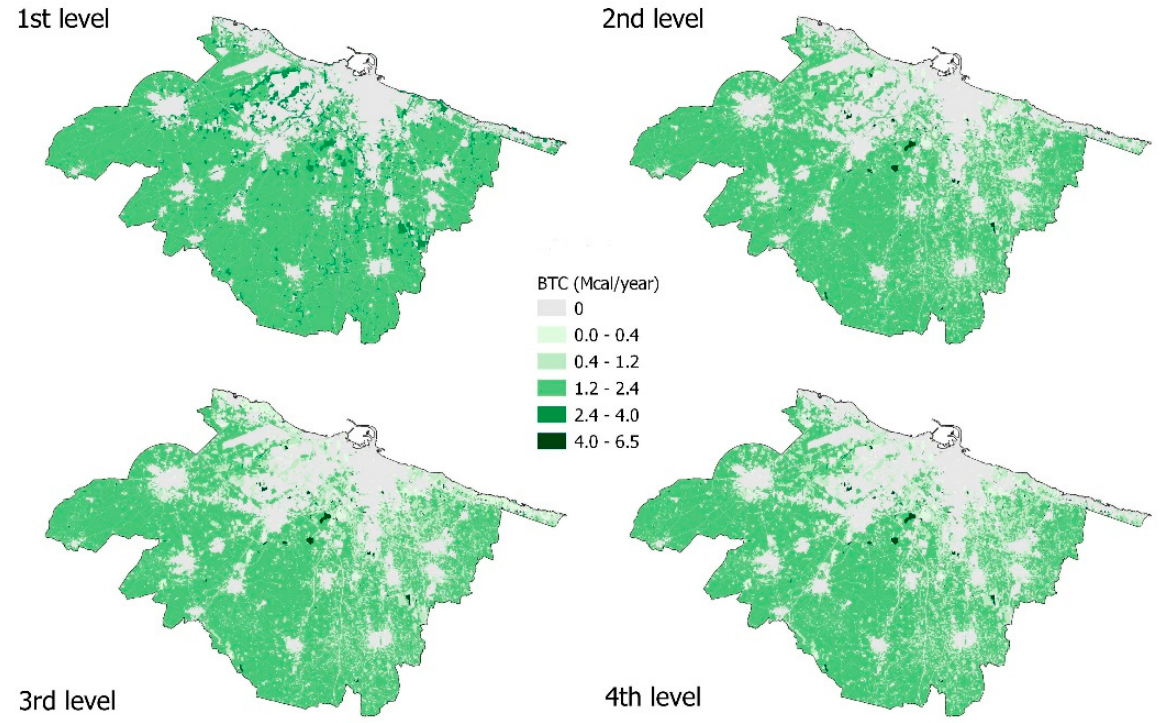
Figure 3. BTC distribution among the four CORINE levels. See appendix A for detailed BTC values.